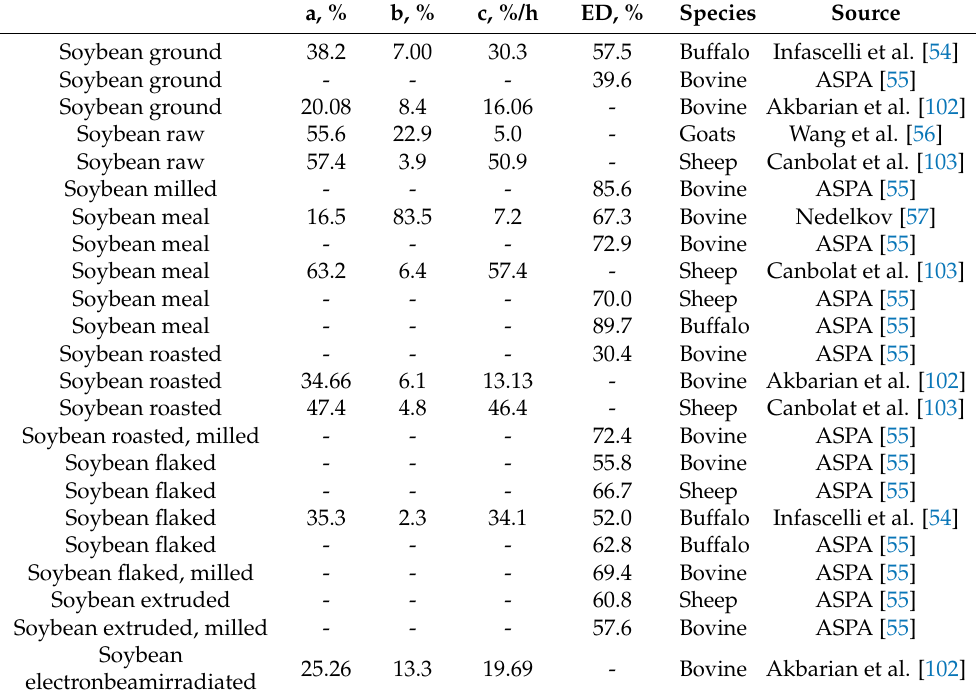
Table 7. Protein degradability of raw and treated